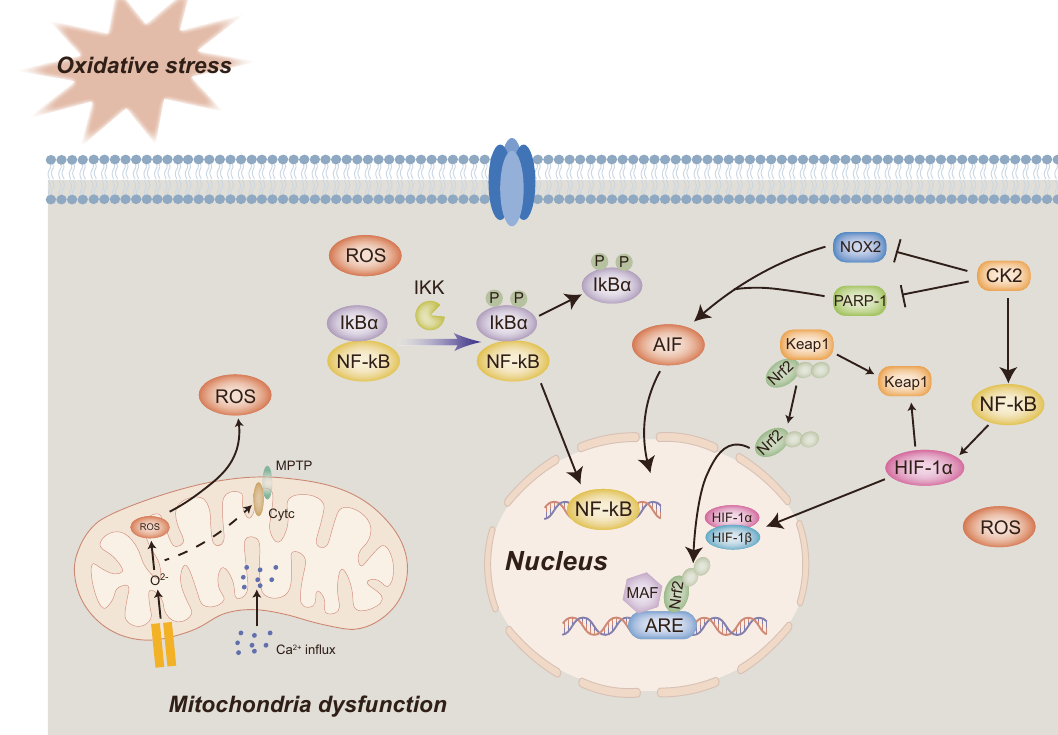
Fig. 4 Oxidative stress and mitochondrial dysfunctions and signaling pathways involved in ischemic stroke. MPTP mitochondrial permeability transition pore, ROS Reactive oxygen species, ATPAdenosine triphosphate, HIF-1 Hypoxia-induced factor, Nrf2 Nuclear factor E2-related factor 2, ARE Antioxidant response element, CK2 Casein kinase 2, PARP-1 Poly ADP-ribose polymerase 1 , AIF Apoptosis-inducing factor, PINK1 PTEN induced putative kinase 1, NF-kB Necrosis